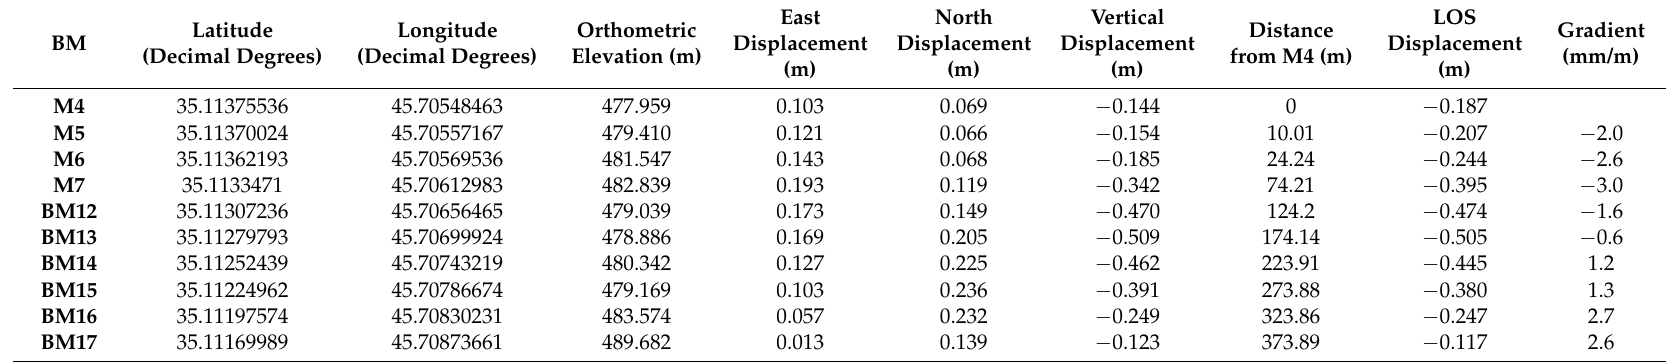
Table 2. The gradient of LOS displacement simulated from the global positioning system (GPS) and levelling data collected in March and November 2017 on the dam crest benchmarks. The incidence angle of the radar LOS is 45.65 ◦ , and the azimuth of the satellite flight is 260.59 ◦